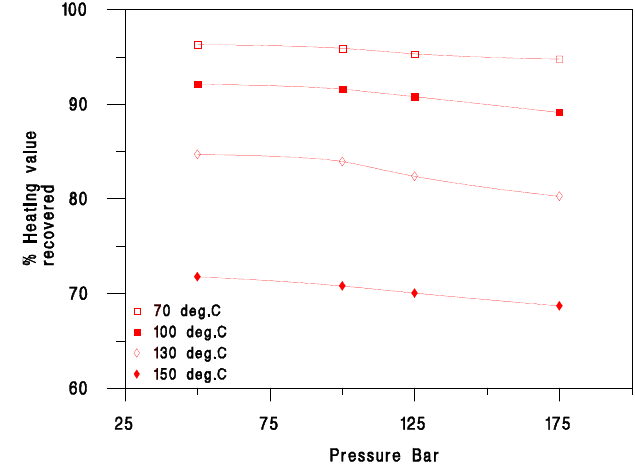
Figure 13. Effect of oxygen partial pressure on heating value recovery of Prince of Wales coal.